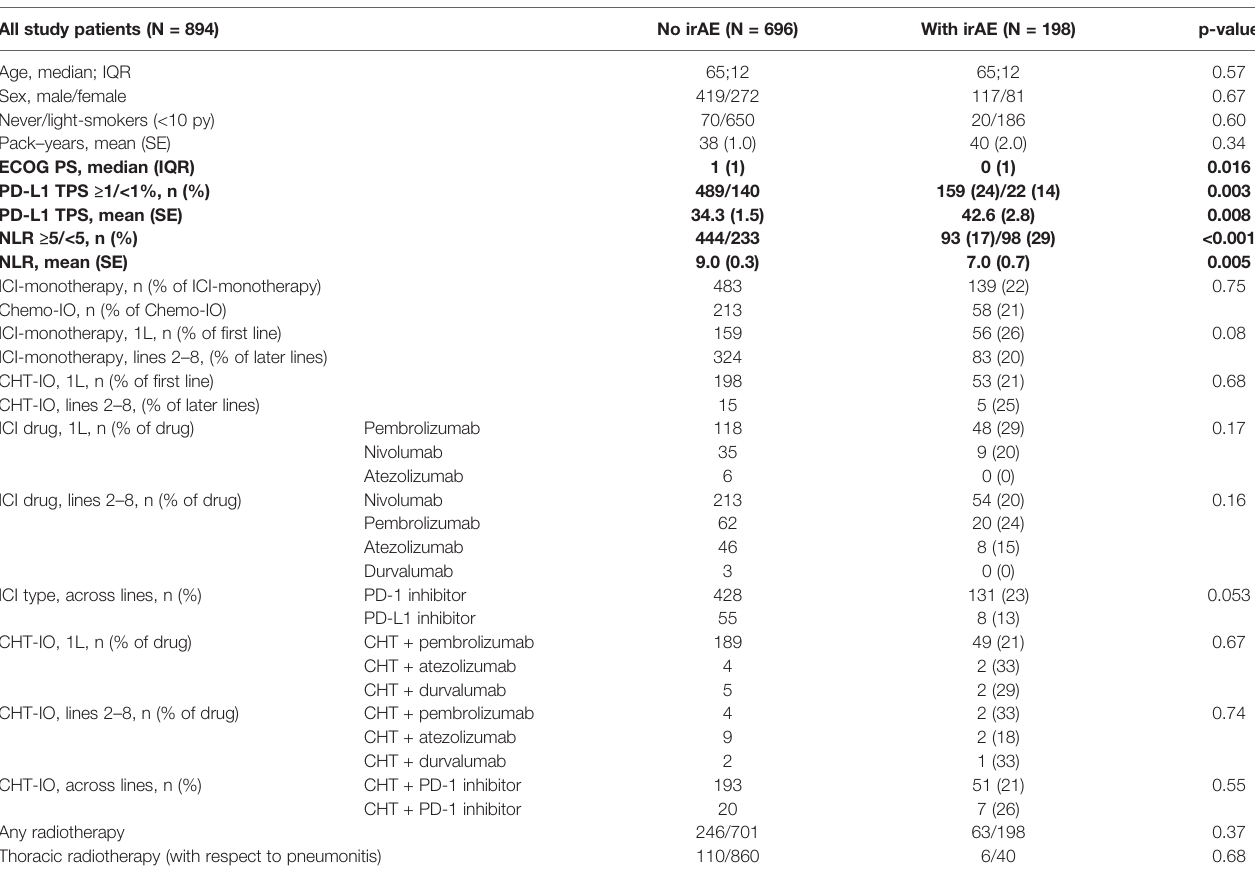
TABLE 1 | Characteristics of stage IV NSCLC patients. All study patients (N =